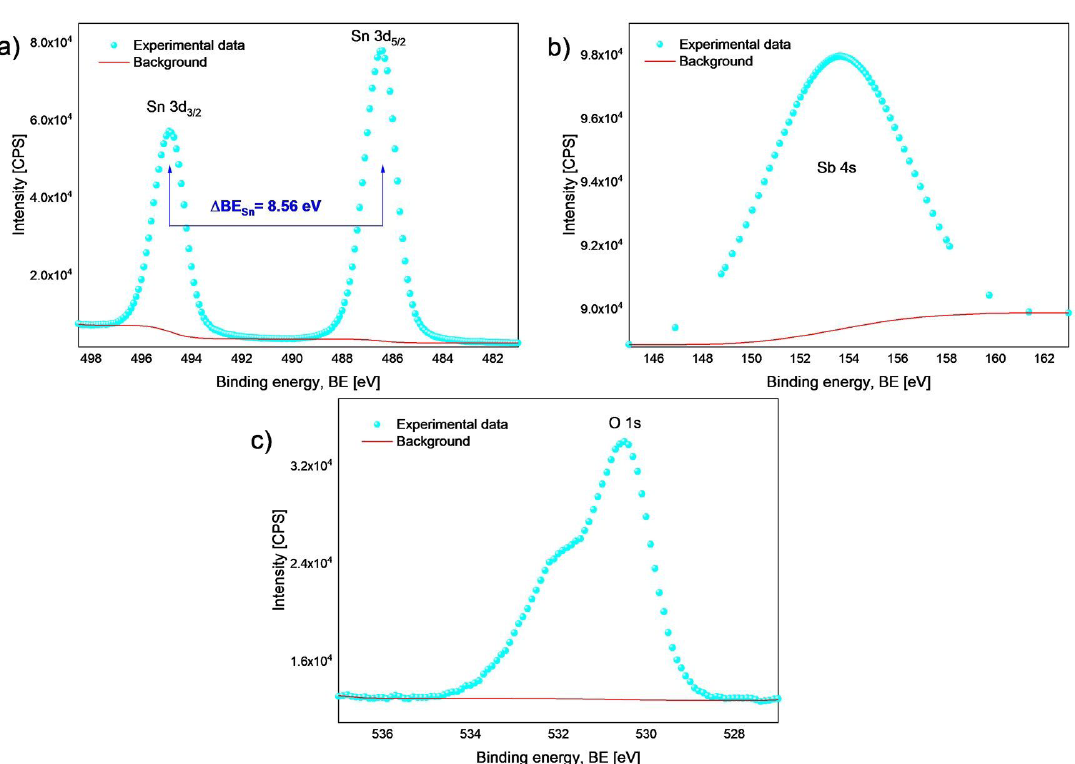
Figure 5. HR-XPS spectra of the as-prepared ATO thin films a) Sn 3d level: Sn 3d3/2 and Sn 3d5/2 levels are labelled, b) Sb 4s level and c) O 1s